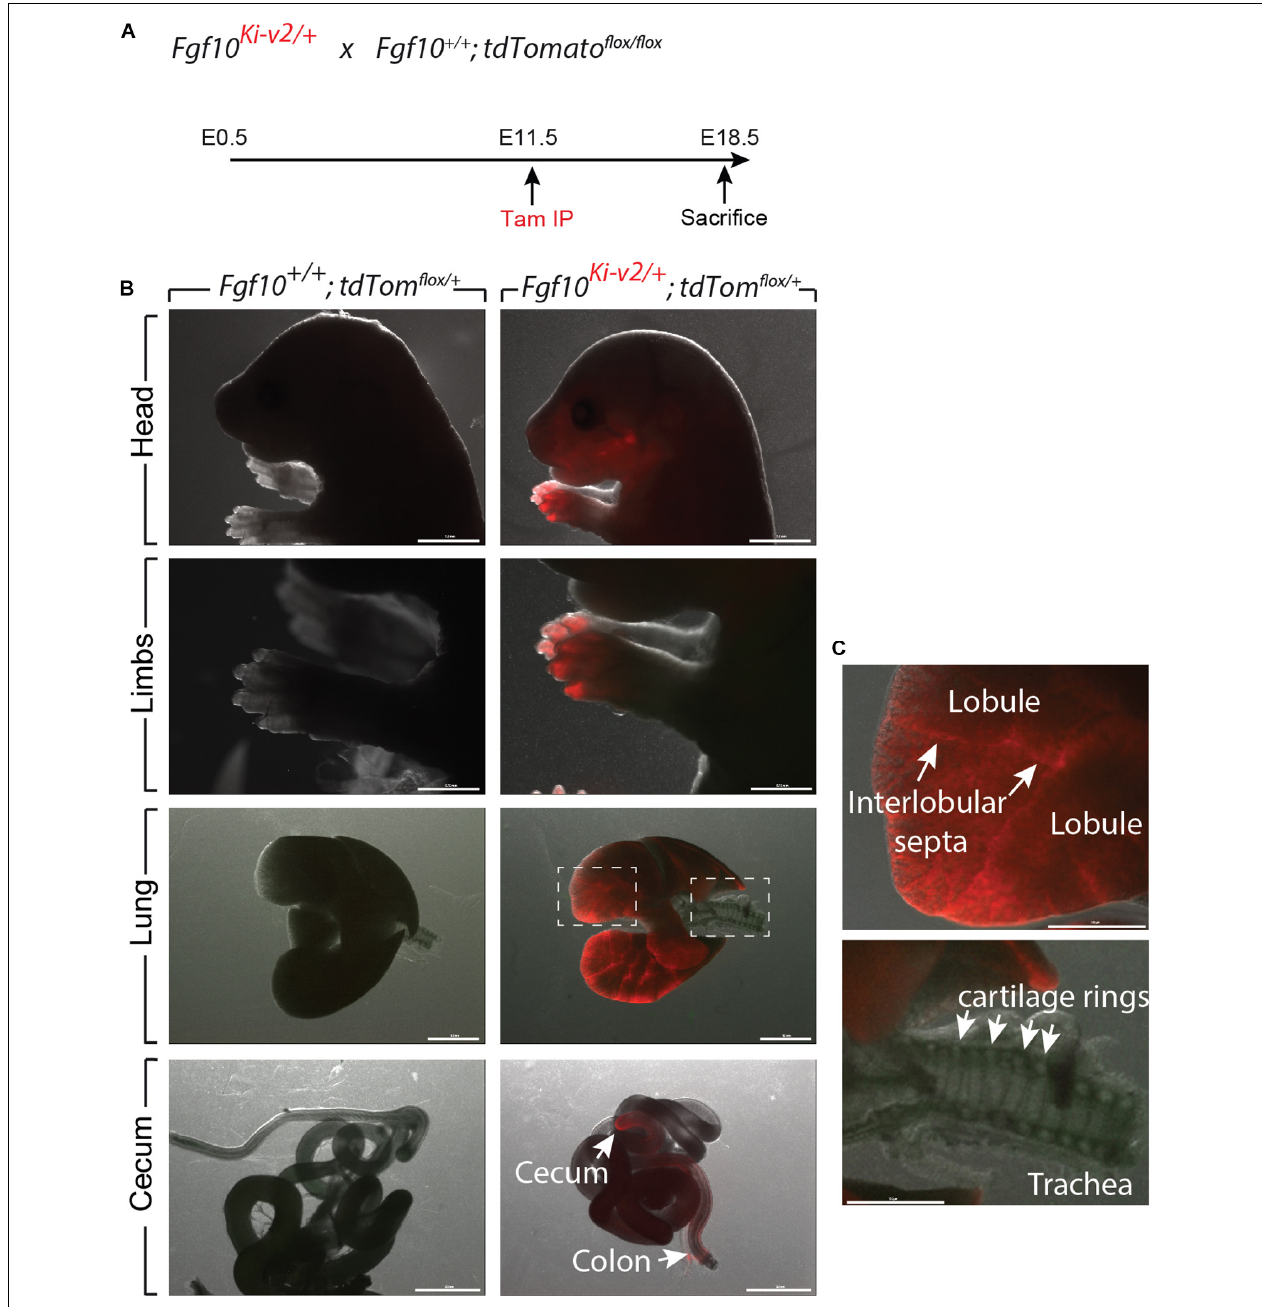
FIGURE 3 | Validation of the labeling of FGF10 Pos cells at E11.5. (A) Fgf10 Ki - v 2 / + were crossed with Fgf10 + / + ; tdTom flox / flox mice. Pregnant females received a single IP injection of tamoxifen when the embryos were at E11.5 and sacrificed at E18.5. (B) Head, limbs, lung and cecum of Fgf10 + / + ; tdTom flox / + and Fgf10 Ki - v 2 / + ; tdTom flox / + embryos are shown. Note the absence of fluorescence in the Fgf10 + / + ; tdTom flox / + indicating that the non-recombined LoxP-Stop-LoxP-tdTomato allele is not leaky. (C) Higher magnification of lung and trachea showing enriched tdTomato expression in the interlobular septa and the lack of tdTomato expression between the cartilage rings, respectively. Scale bar in (B) : head: 1.5 mm, Limb: 0.75 mm, Lung: 0.5 mm, cecum: 0.5 mm. Scale bar in (C) : 125 µ